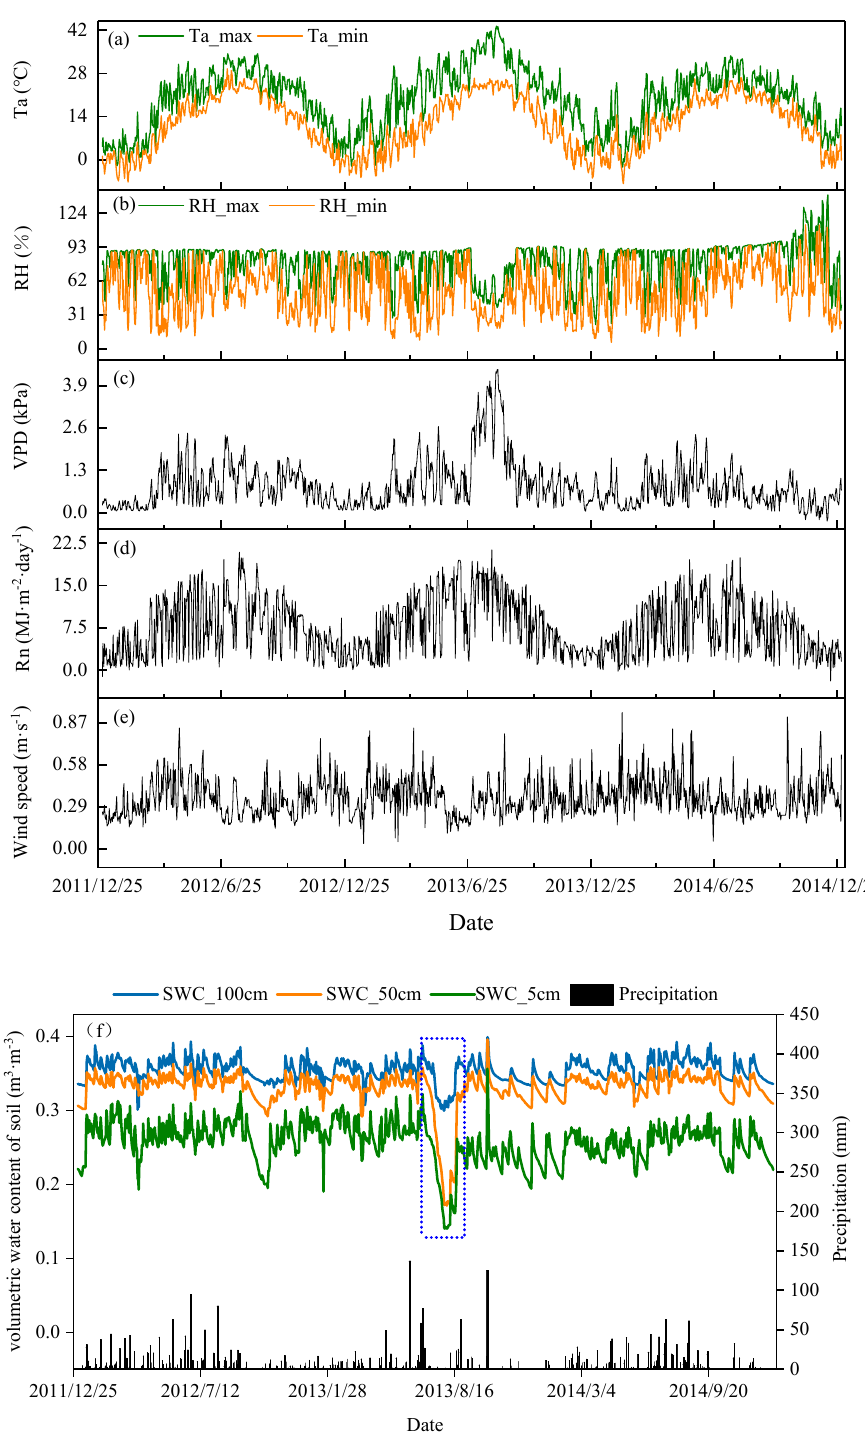
Figure 2. The daily dynamics of environmental variables in the Moso bamboo forest in Anji country from 2012–2014. ( a ) Air temperature: green line represents the maximum daily temperature (Ta_max) and the orange line represents the minimum daily temperature (Ta_min); ( b ) relative humidity: green line represents the maximum relative humidity (RH_max) and the orange line represents the minimum relative humidity (RH_min); ( c ) vapor pressure deficit (VPD, kPa); ( d ) net radiation (Rn, MJ · m − 2 · day -1 ); ( e ) wind speed (m · s − 1 ), ( f ) precipitation (P, mm), and soil volumetric water content (SWC, m 3 · m − 3 ) > SWC_5 cm, SWC_50 cm, and SWC_100 cm are the volumetric water content of soil at a depth of 5 cm, 50 cm, and 100